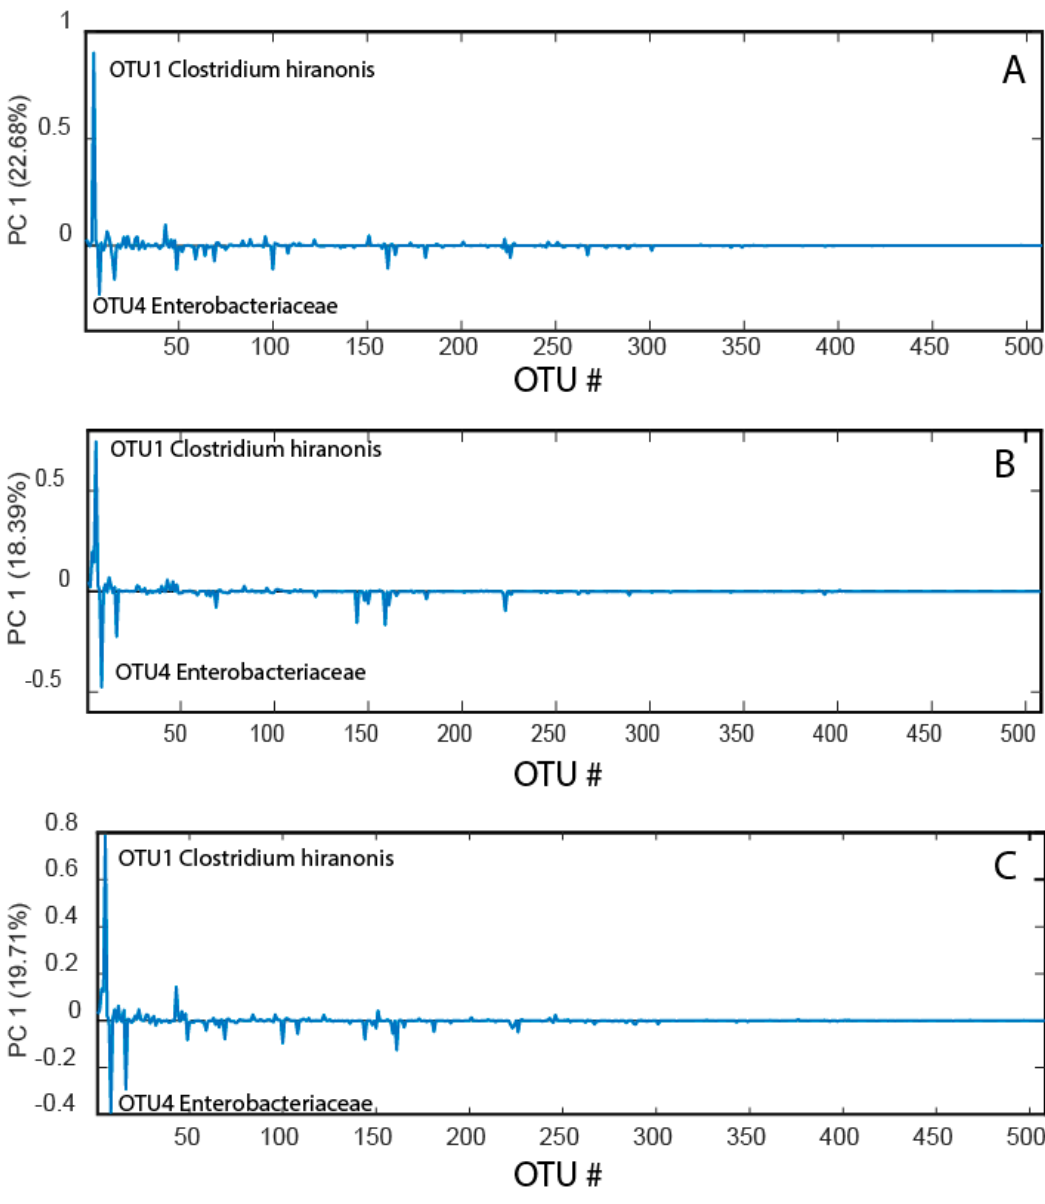
Figure 2. Bacterial loadings before the race ( A ), after the race ( B ), and changes from before to after the race ( C ). The bacterial loadings were derived from the first principal component in a PCoA model for the mean-centered operational taxonomic unit (OTU) table.